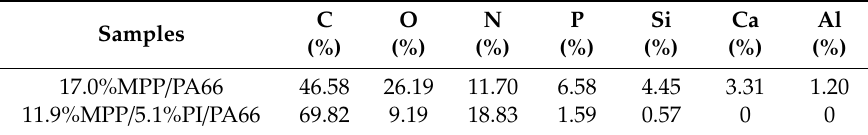
Table 4. The element weight percentages of middle-tier residue in EDX.